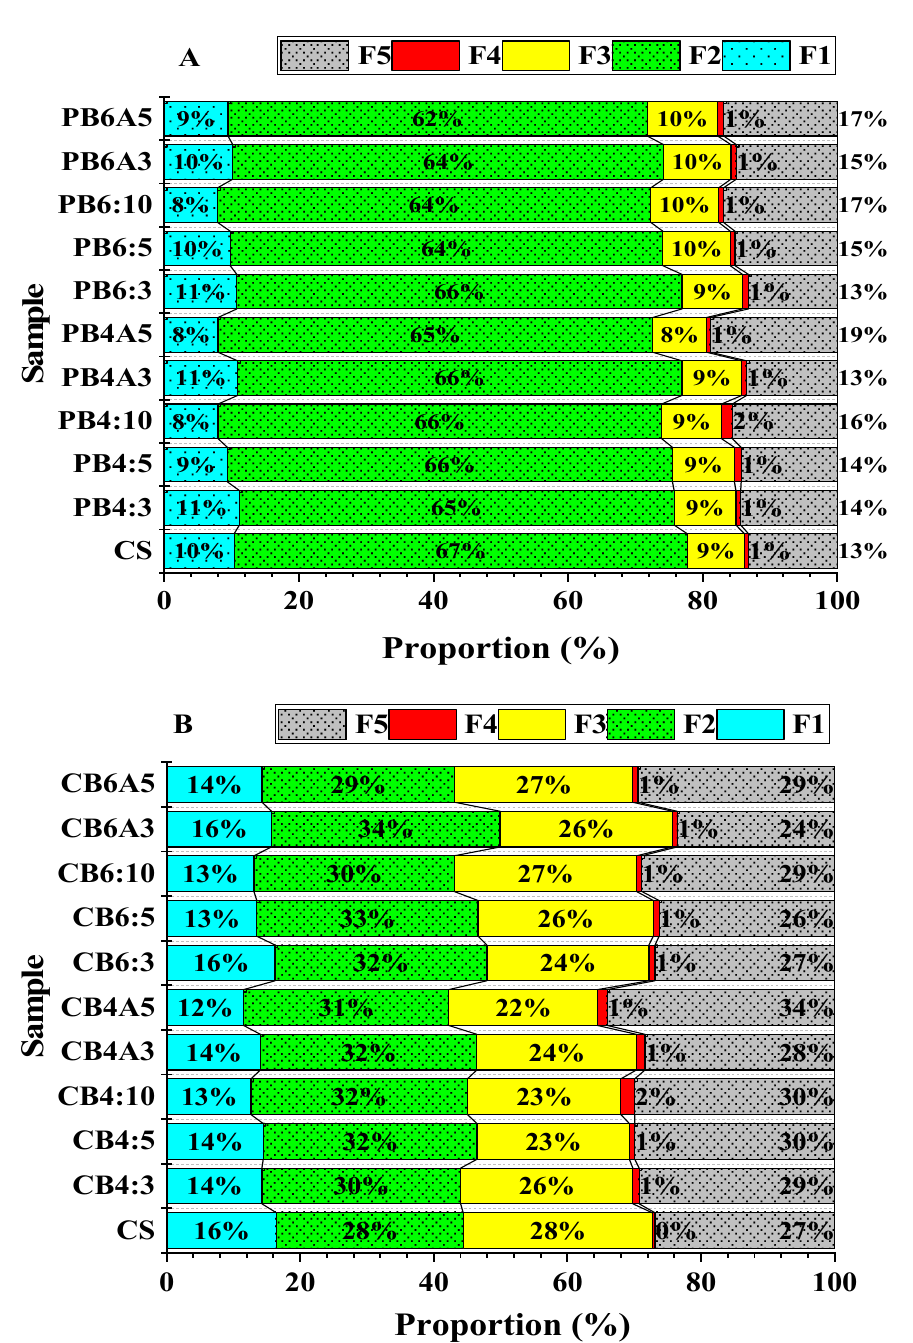
Figure 4. Fractionations of Pb ( A ) and Zn ( B ) in the control soil and amended soil samples.